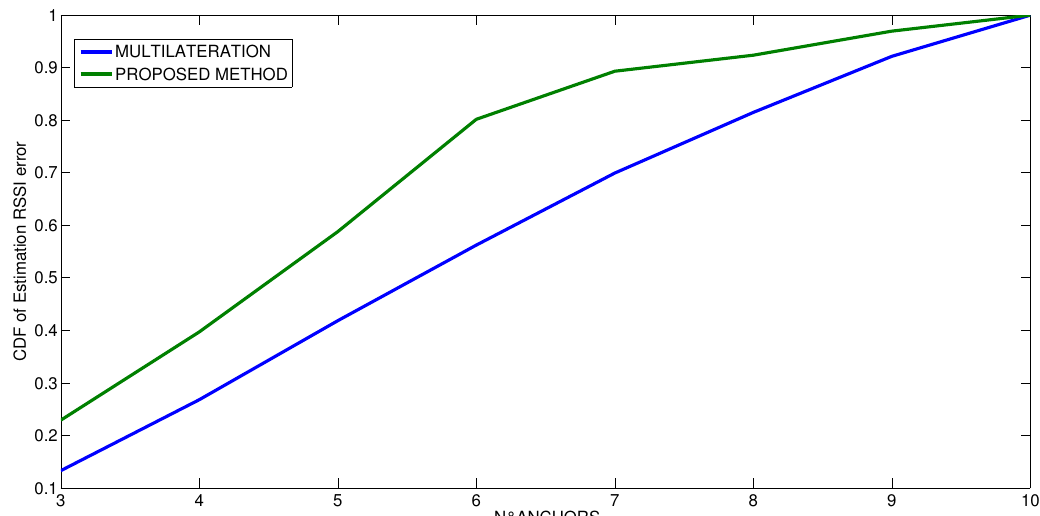
Figure 13. Cumulative Distribution Function of the RSSI estimation error at varying number of anchors for the flat